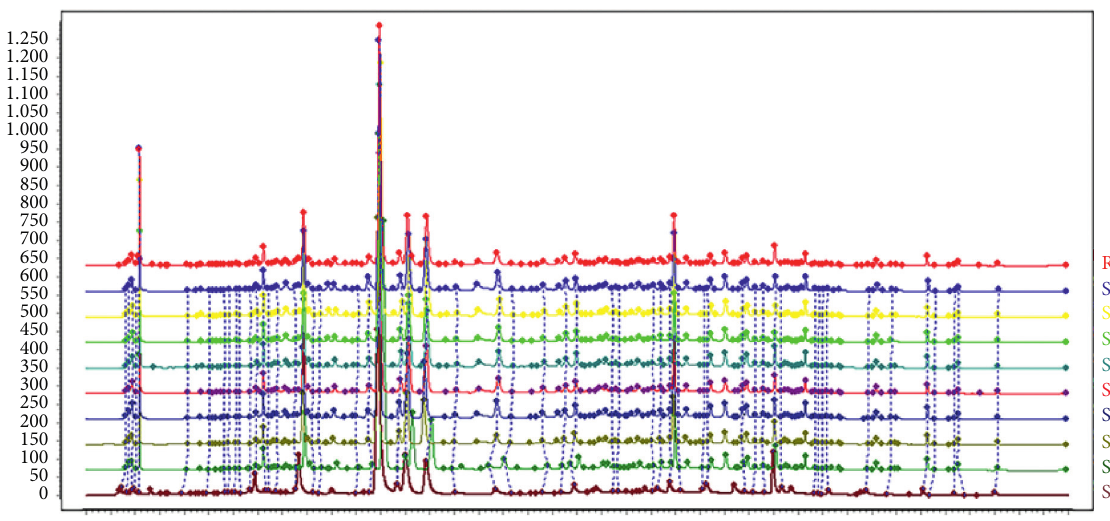
Figure 1: HPLC fingerprints of YYTN and their reference (the detection wavelength was set at 280nm, and the time is expressed in minutes).